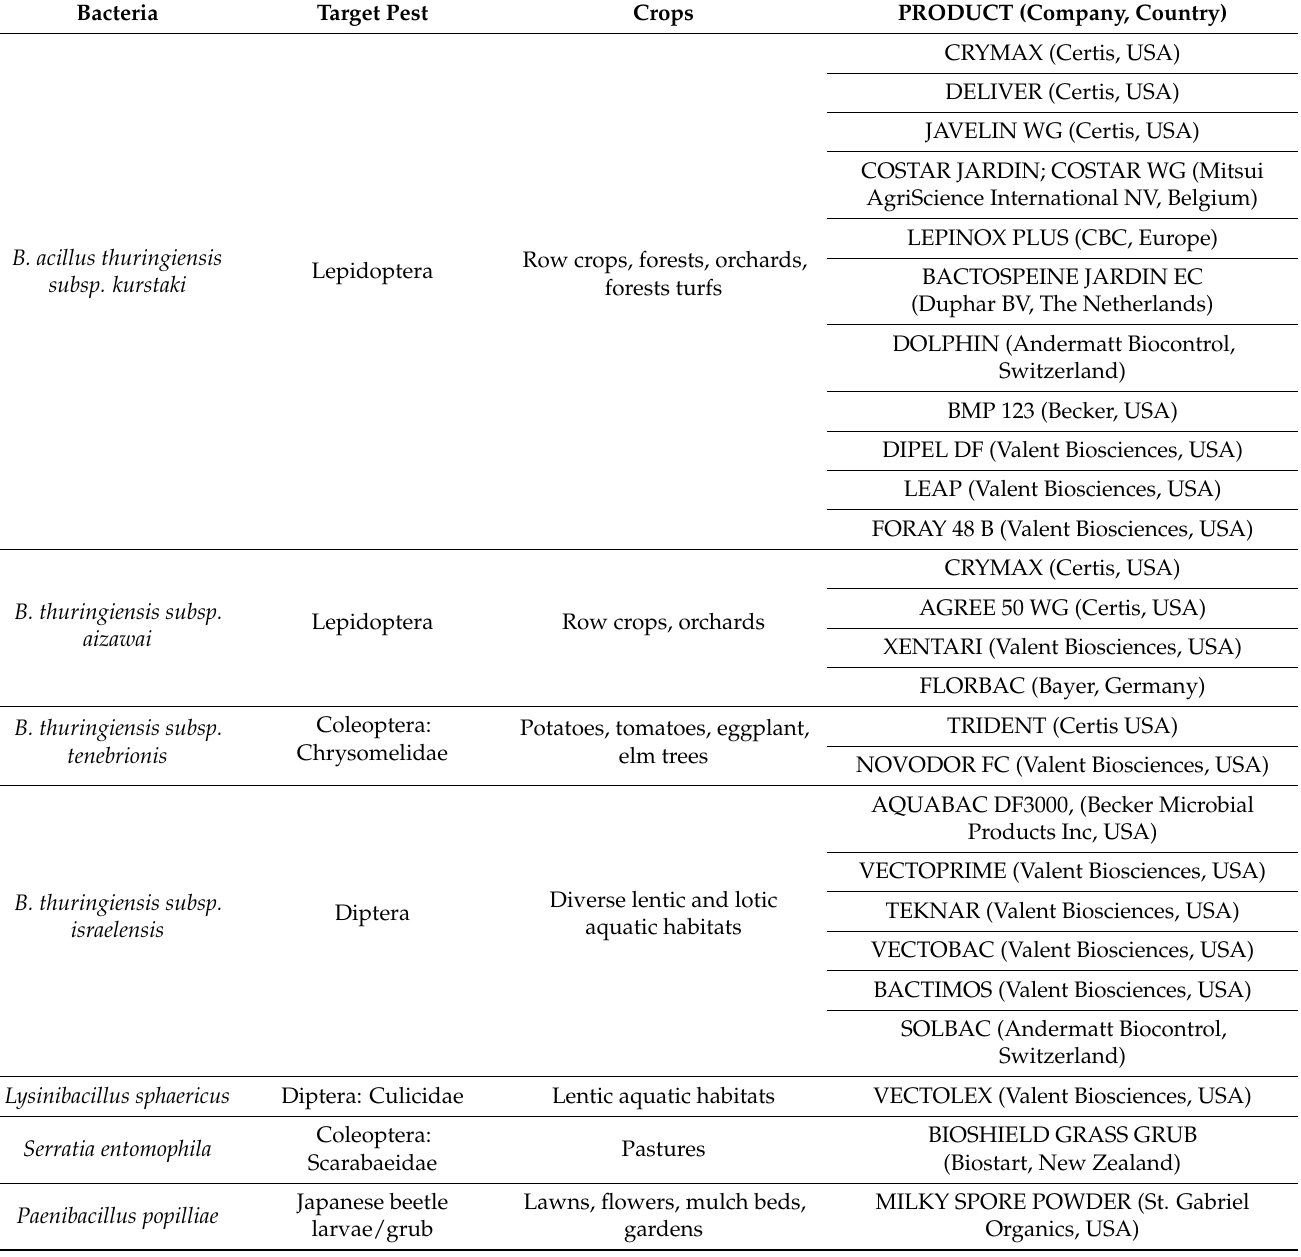
Table 1. Examples of common commercially available entomopathogenic bacteria (EPB) and their target insect groups.